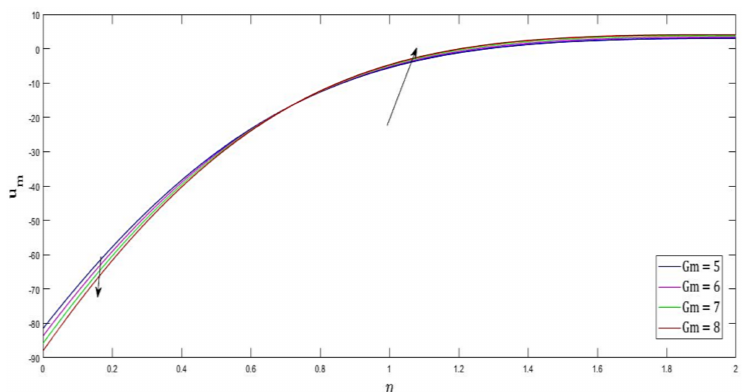
Figure 4. Variation in velocity profile with respect to mass Grashof number.